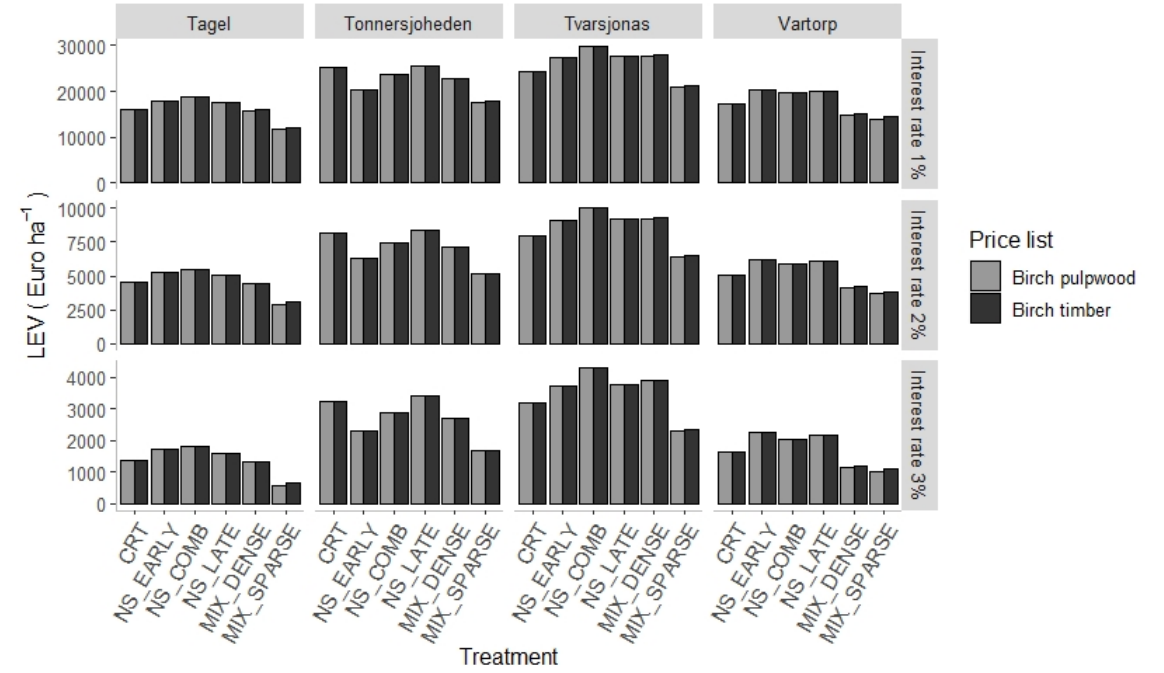
Figure 5. Land expectation value (LEV) of each stand at different sites, interest rates, and grading of birch logs after a full rotation. Here, logs greater than 14 cm in top diameter were assorted as timber and thinner trees were assorted as pulpwood (birch timber). All logs irrespective of dimen- sion were assorted as pulpwood (birch pulpwood). See Figure 3 for an explanation of the